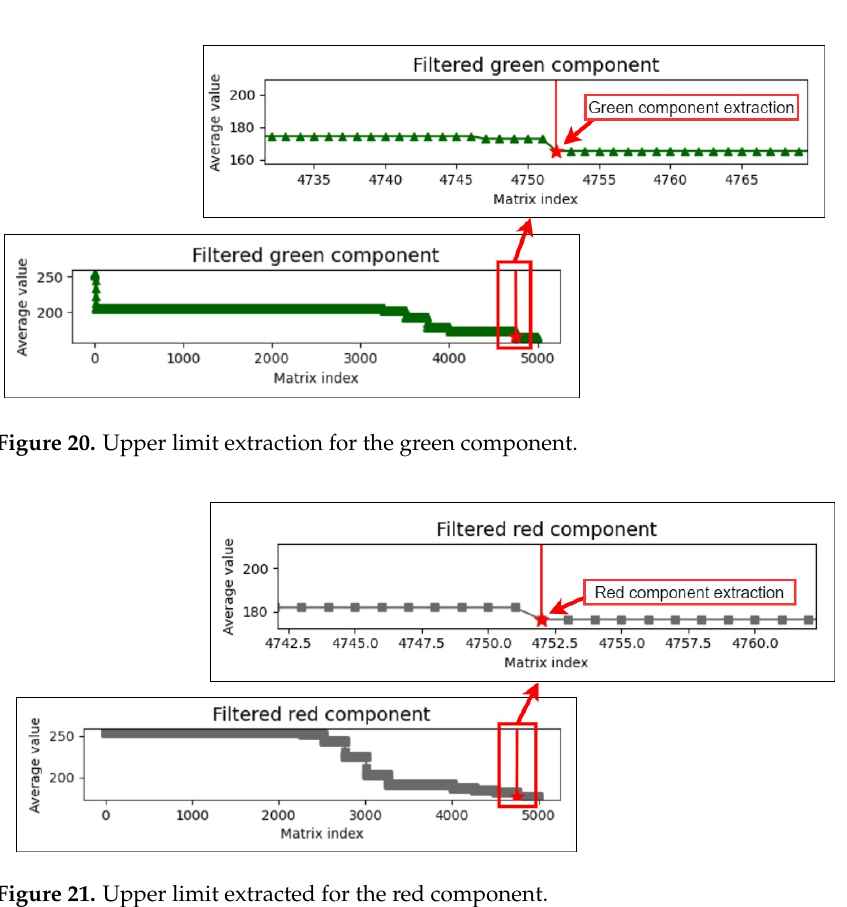
Figure 19. Upper limit extraction for the blue component.